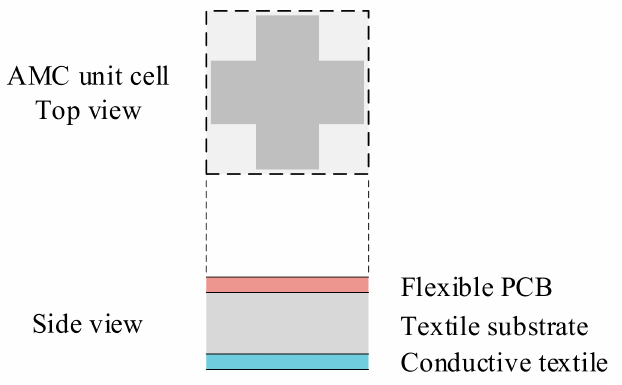
Figure 6. Top view and side view of the AMC structure.